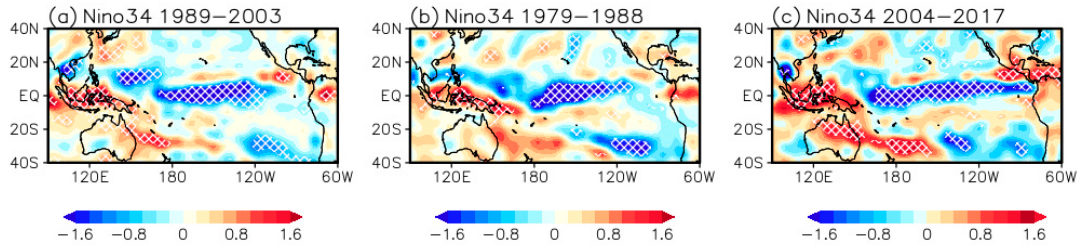
Figure 9. Linear regression maps of the Niño3.4 index with the summer vertical velocity field (omega) at 500 hPa during ( a ) 1989 – 2003; ( b ) 1979 – 1988; and ( c ) 2004 – 2017 (unit P/s); the vertical velocity has been multiplied by 100. The gridded regions represent the correlations that are positively and negatively significant at the 95% confidence level.